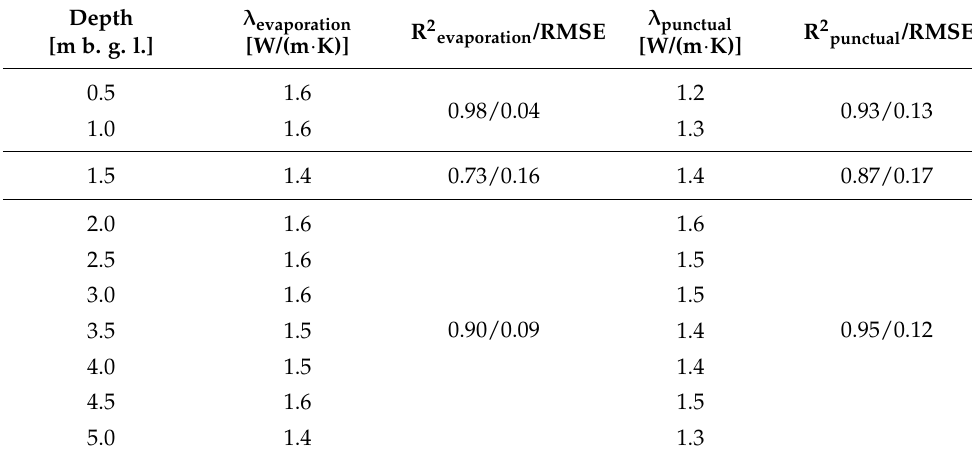
Table 8. Thermal conductivity per depth step using regression with a second-degree polynomial function as a function of the gravimetric water content for the evaporation method ( λ evaporation ) and the punctual method ( λ punctual ). The quality of the respective regression is shown in the form of the coefficient of determination (R 2 ) and Root Mean Square Error